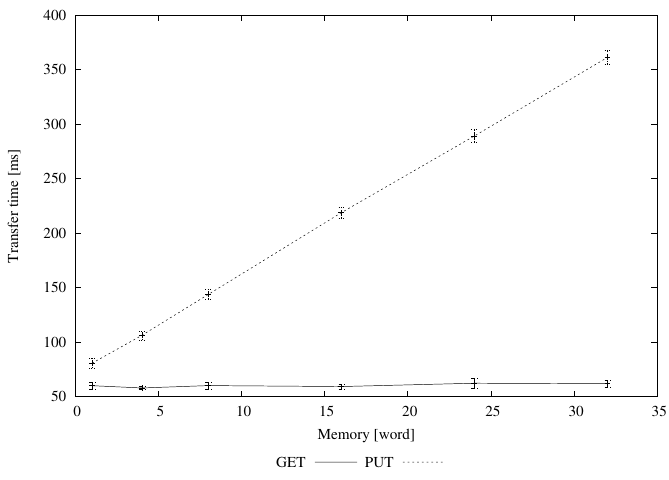
Figure 8. Execution